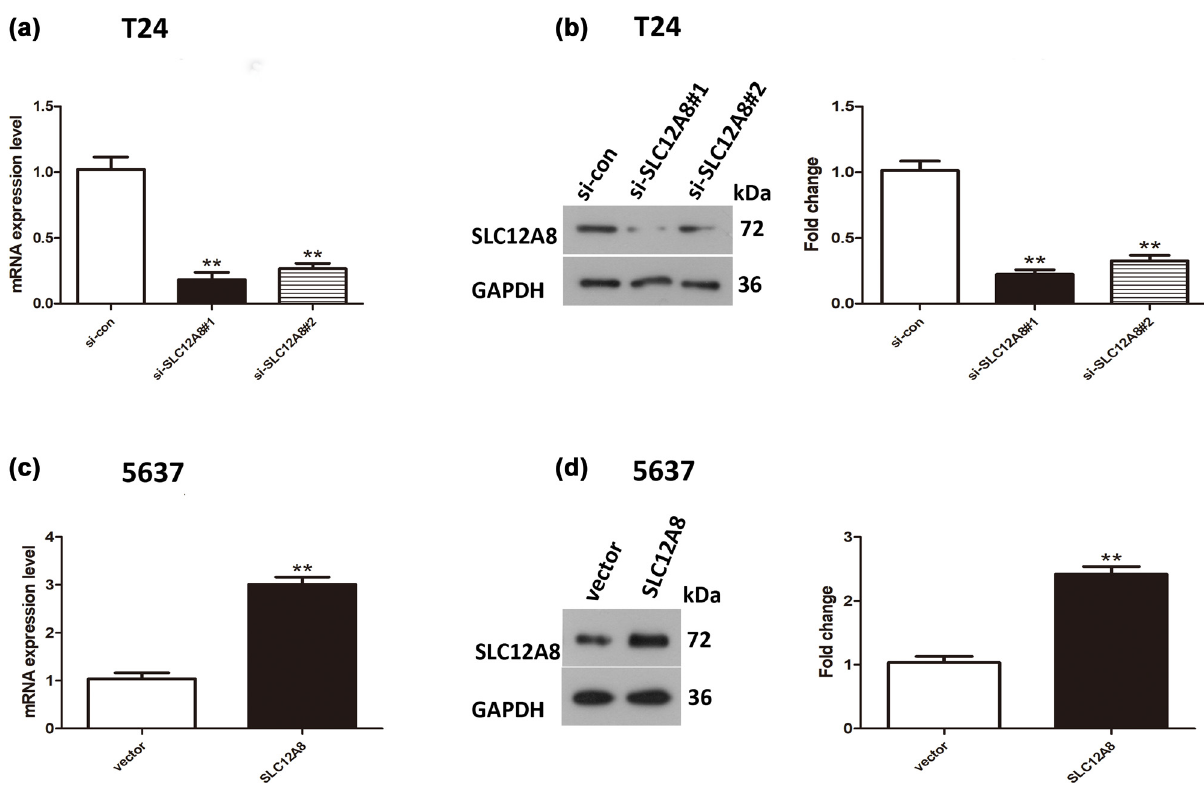
Figure 2: Expression of SLC12A8 mRNA and protein in bladder cancer cells transfected with si - SLC12A8 or pcDNA3.1 - SLC12A8. ( a ) The SLC12A8 mRNA expression levels were decreased in T24 cells after transfection with si - SLC12A8#1 or si - SLC12A8#2, ** p < 0.01. ( b ) The SLC12A8 protein expression was decreased in T24 cells with depleted SLC12A8, ** p < 0.01. ( c ) The mRNA - SLC12A8 expression level was remarkably increased in 5,637 cells with upregulated SLC12A8, ** p < 0.01. ( d ) The SLC12A8 protein expression was notably higher in 5,637 cells with upregulated SLC12A8, ** p <